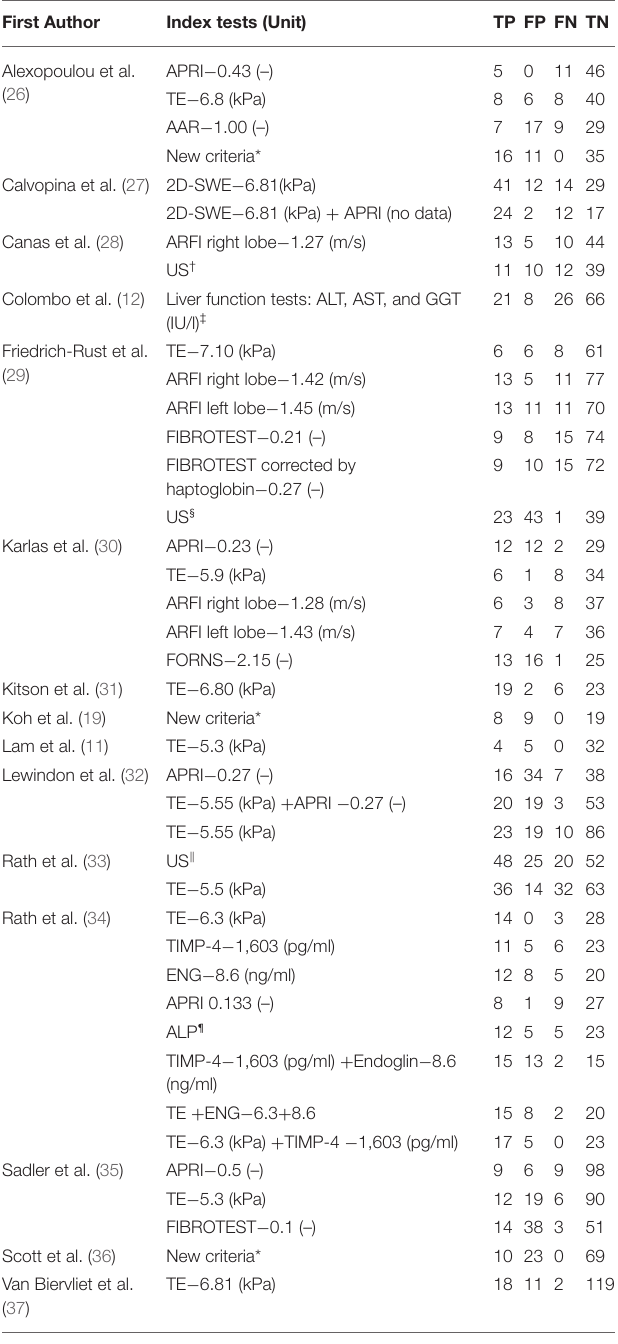
TABLE 2 | Summary of the diagnostic modalities with index tests and raw